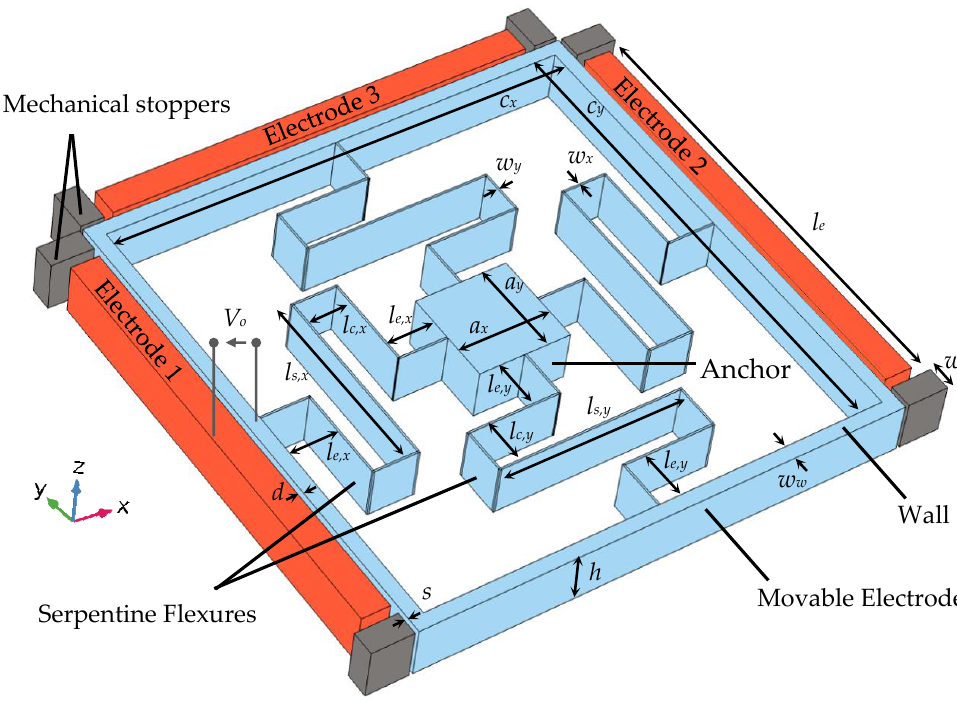
Figure 3. Three-dimensional schematic of the proposed AUC for the cooperative microactuator system, taken from the FEM model in COMSOL. Table 1. Typical parameter values for the AUC in the FEM